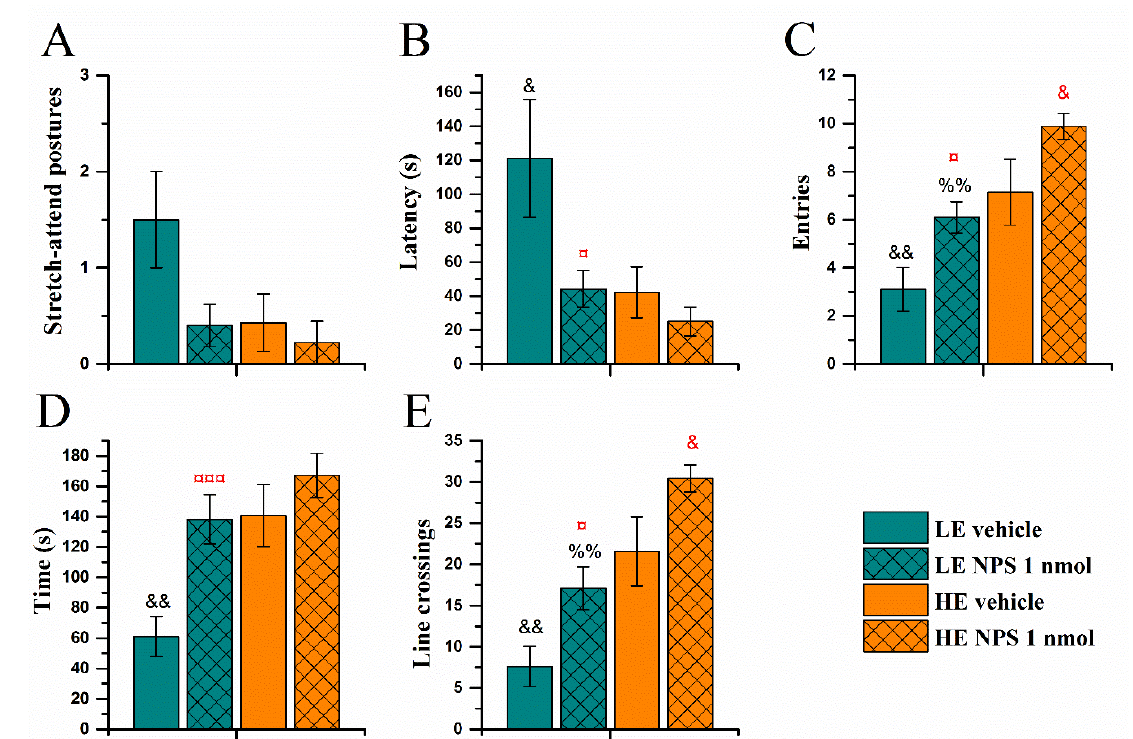
Figure 7. Behaviour in the elevated zero-maze approximately 35 min after vehicle/NPS (1 nmol, i.c.v.) administration: strech-attend postures ( A ), latency to enter ( B ), entries into ( C ), time spent, ( D ), and line crossings ( E ) in the open quadrants of the apparatus (data shown as mean ± SEM). &, &&: p < 0.05, 0.01 vs. HE vehicle, respectively; ¤, ¤¤¤: p < 0.05, 0.001 vs. LE vehicle, respectively; %%: p < 0.01 vs. HE NPS. Red colour denotes difference from respective vehicle group. HE: high exploring rats; LE: low exploring rats; NPS: neuropeptide S. HE vehicle ( n = 7); HE NPS ( n = 9); LE vehicle ( n = 10); LE NPS ( n = 10).